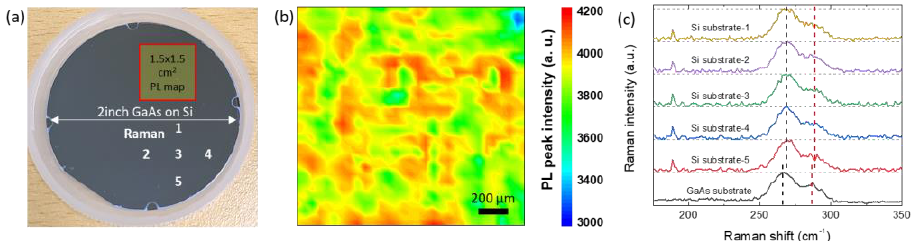
Figure 3. ( a ) Photograph of a 2-inch GaAs one-junction solar cell grown on Si substrate. The red-line square shows the selected area for micro-PL mapping. ( b ) Micro-PL mapping image on the selected area in ( a ). ( c ) Raman spectra of GaAs solar cell grown on GaAs and Si substrate.